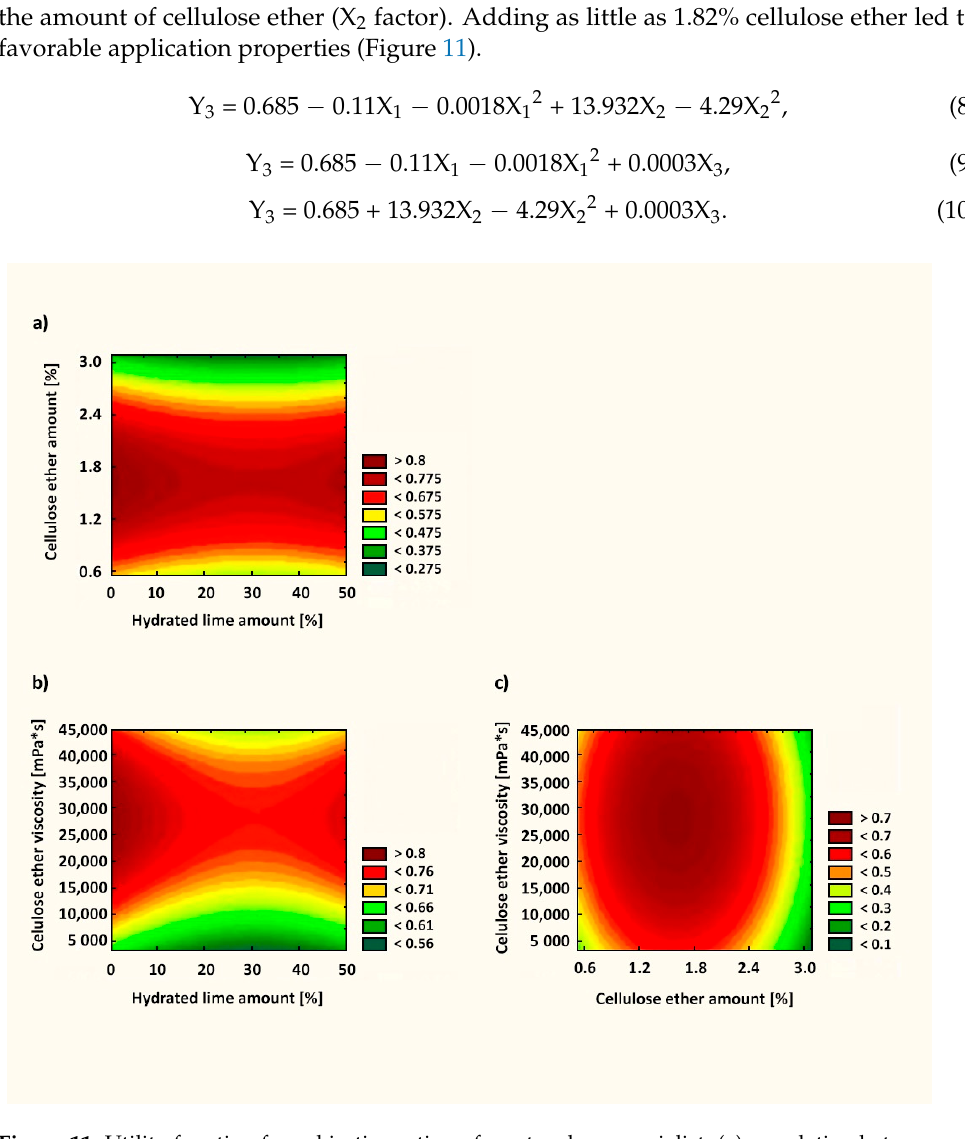
Figure 11. Utility function for subjective rating of mortars by a specialist: ( a ) correlation between cellulose ether amount and hydrated lime amount; ( b ) correlation between cellulose ether viscosity and hydrated lime amount; ( c ) correlation between cellulose ether viscosity and cellulose ether amount.